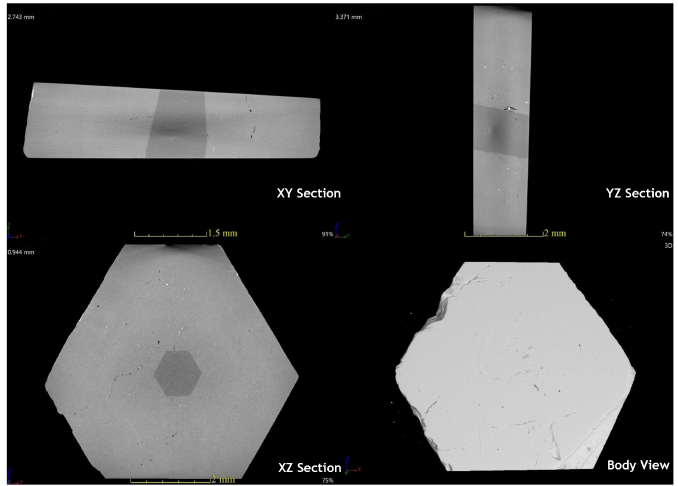
Figure 4. The inner structure of the gem can be observed from three different sections, and the three-dimensional structure of the sample can also be observed from the body view.